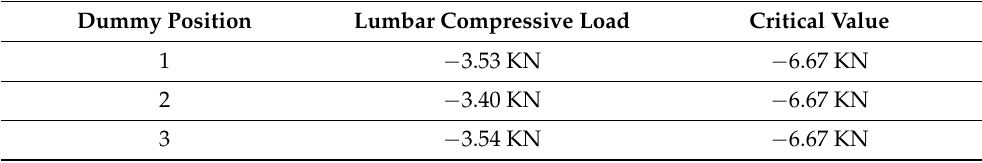
Figure 19. Test 3: Dummy 3’s compressive force (KN) vs. the time (ms) of ( a ) the left femur and ( b ) the right femur.